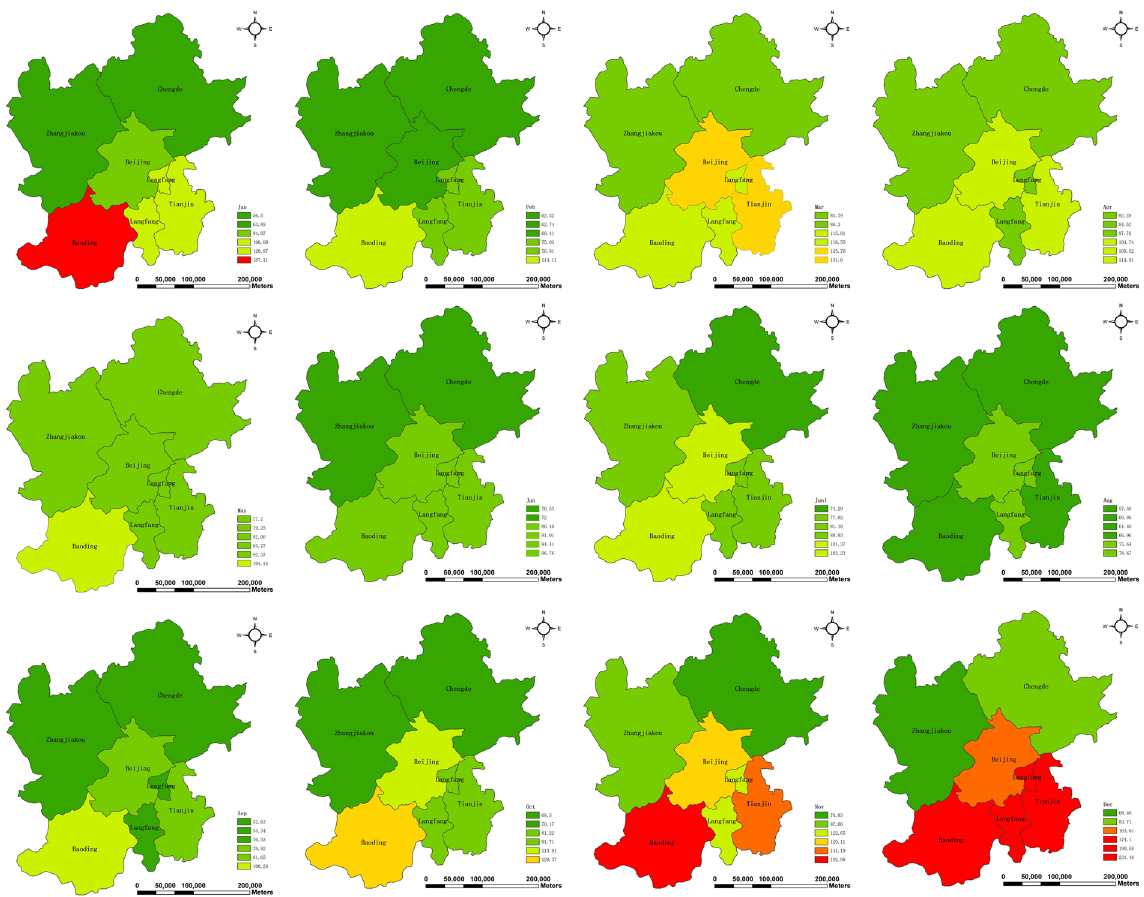
Figure 4. Spatial distribution of monthly average values of AQI. The maps were generated using ArcGIS (Version 10.3.1., https://www.arcgis.com). The source of the map is GADM database of Global Administrative Areas (http://www.gadm.org/). The study area is part of the map of